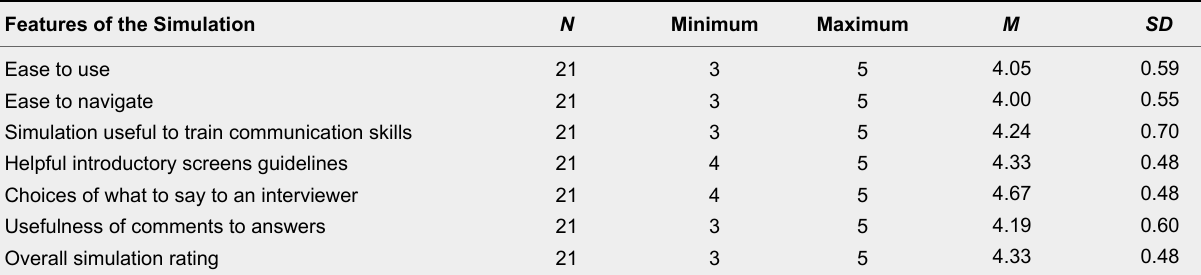
Usability Characteristics of JIST (Scale 1–5; Poor to